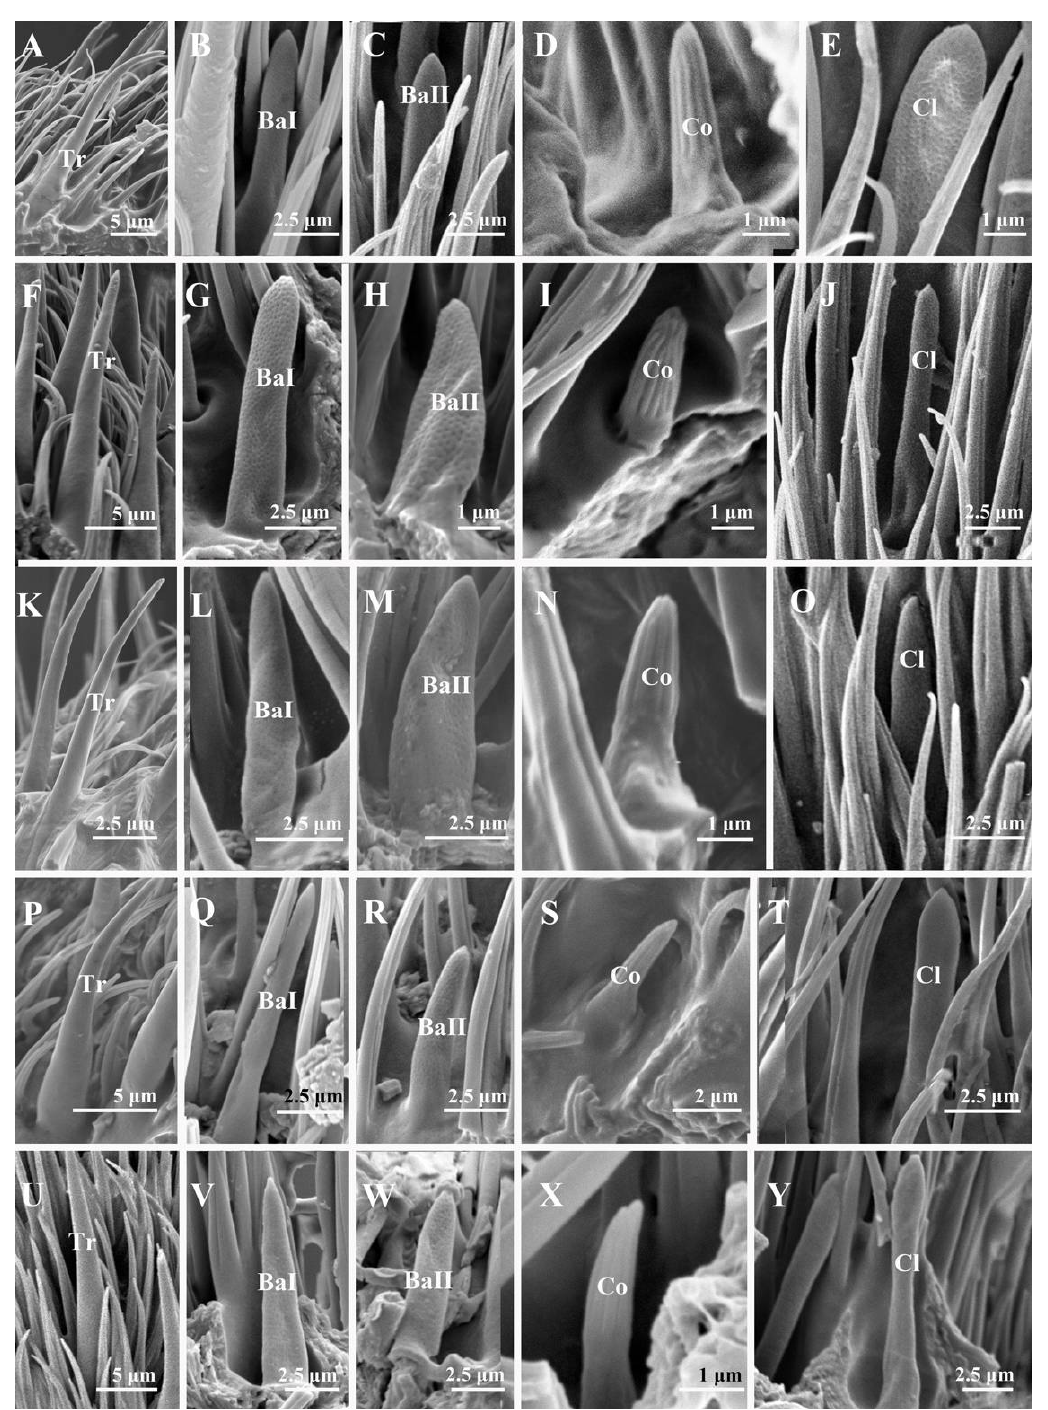
Figure 4. Trichoid sensilla, basiconic sensilla, coeloconic sensilla, and clavate sensilla on the antennal postpedicel of male sarcophagid species. ( A – E ) S . albiceps ; ( F – J ) S . portschinskyi ; ( K – O ) S . 7frica ; ( P – T ) S . peregrina ; ( U – Y ) W . magnifica . Abbreviations: Co (coeloconic sensilla); Cl (clavate sensilla); Ba I (subtype I basiconic sensilla); Ba II (subtype II basiconic sensilla); Tr (trichoid sensilla).